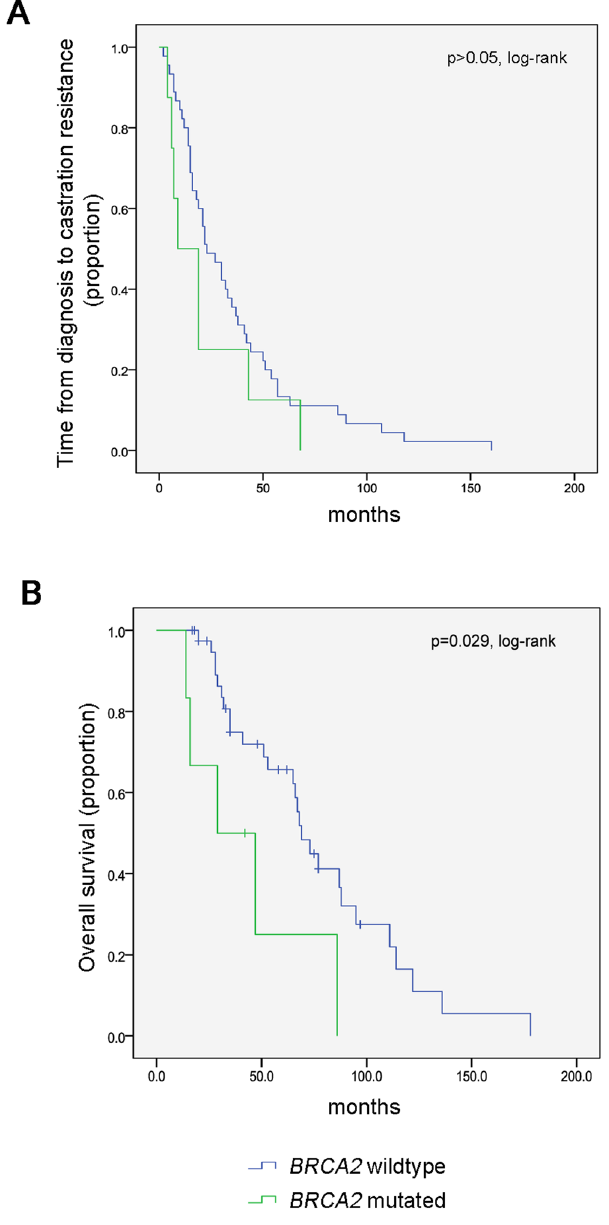
Figure 2. BRCA2 mutation status and patient survival. ( A , B ) Kaplan Meier curves showing time to castration resistance in 45 men who were wildtype for BRCA2 and eight men with a deleterious BRCA2 mutation ( A ). Overall survival ( B ) was significantly shorter in six men with a BRCA2 mutation in comparison to 40 men who carried the wildtype gene (p = 0.029; log-rank test). Differences in the patient number in ( B ) are due to the fact that seven men were lost to follow